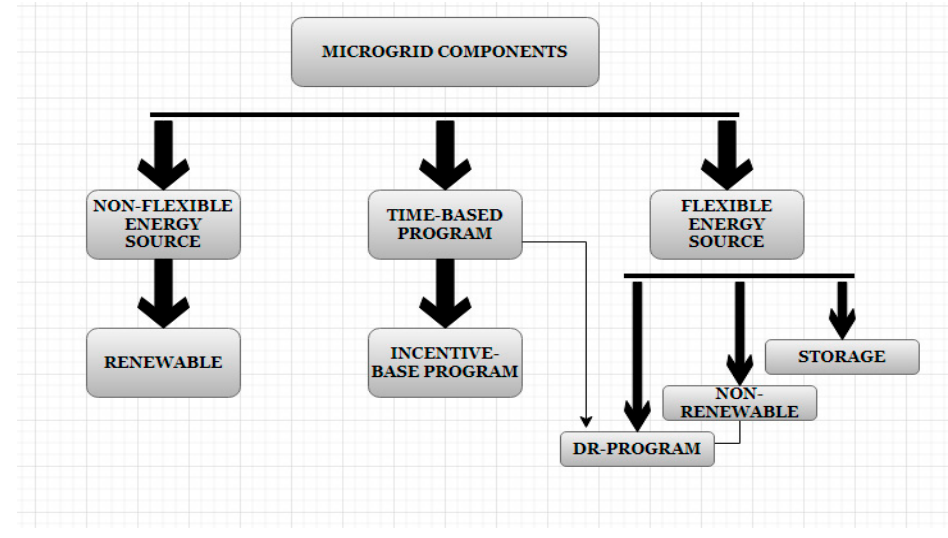
Figure 2. Microgrid Components.